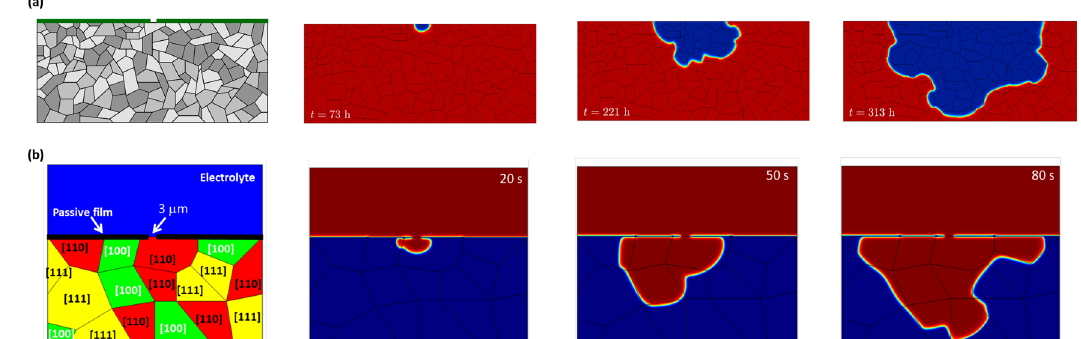
Fig. 6 Crystal orientation-dependent corrosion. a Evolution of a pit in steel with a crystal-orientation dependence using a one-order parameter for all crystal orientations 64 . b MPF model simulations of crystal orientation-dependent corrosion in which each orientation is expressed by one order parameter 80 . a is reproduced with permission from ref. 64 , published by Elsevier in 2016. b is reproduced with permission from ref. 80 , published by nature springer in 2019.